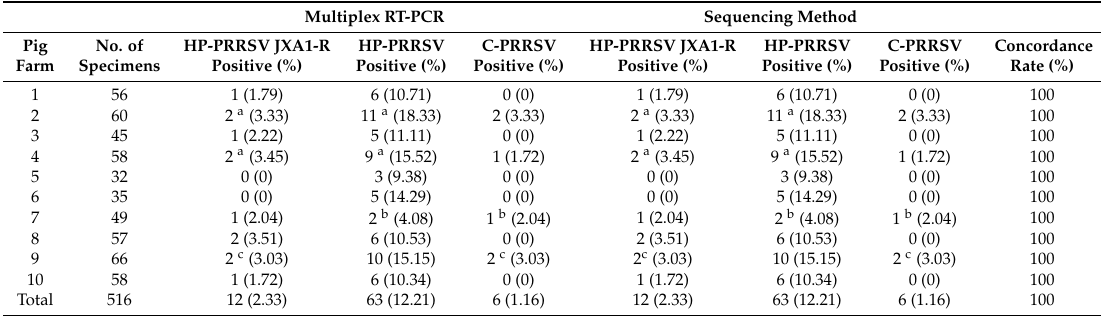
Table 2. Detection rates of clinical specimens by multiplex RT-PCR and sequencing method.